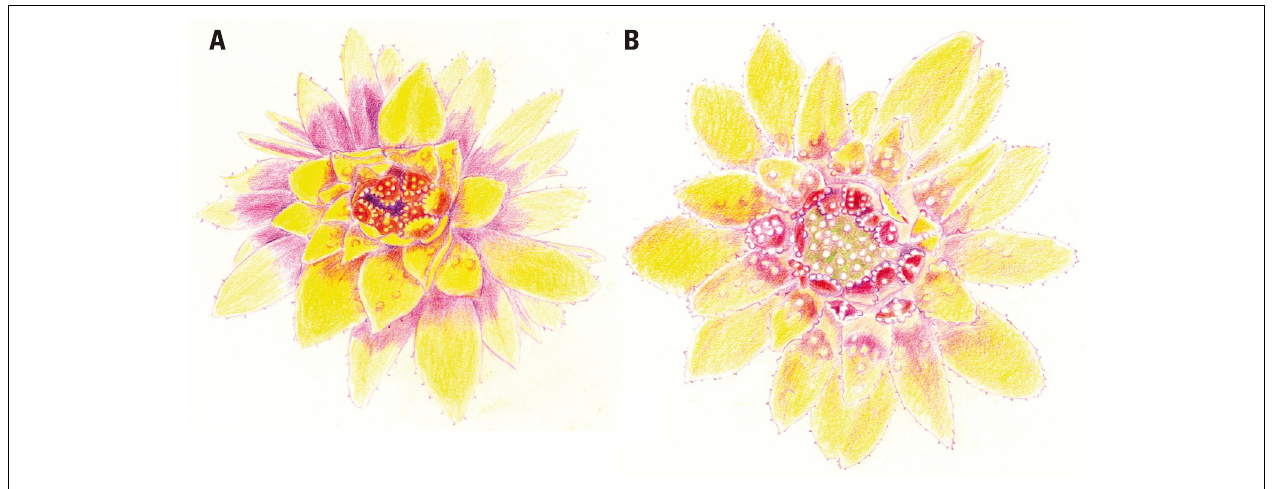
FIGURE 1 | An opening flower of Eupomatia bennettii F. Muell., drawn by Peter Endress on 5 February 1979 at 09.00 h (A) and 14.00 h (B) .The inner staminodes are shown bearing secretory warts during the male phase of